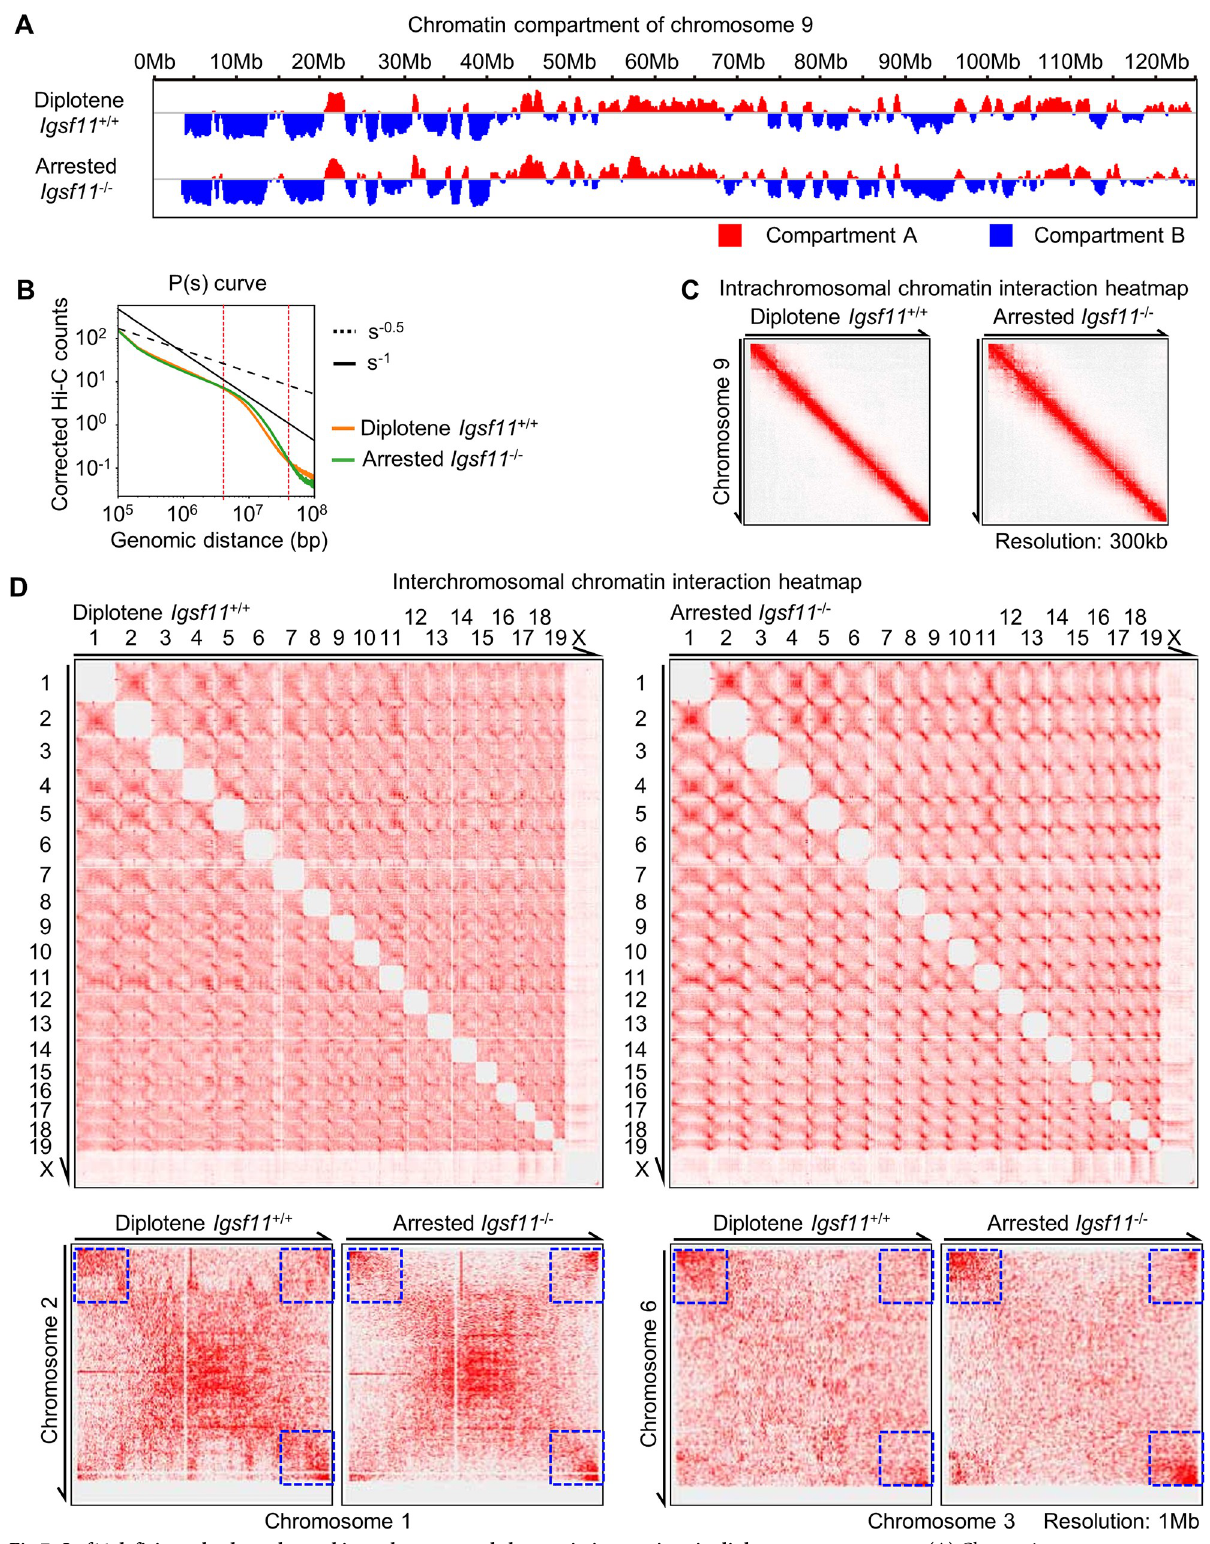
Fig 7. Igsf11 deficiency leads to elevated interchromosomal chromatin interactions in diplotene spermatocytes. (A) Chromatin compartment analysis (chromosome 9 as example) represented by the PC1 values for Hi-C data of spermatocytes of the control ( Igsf11 +/+ ) and mutant ( Igsf11 -/-